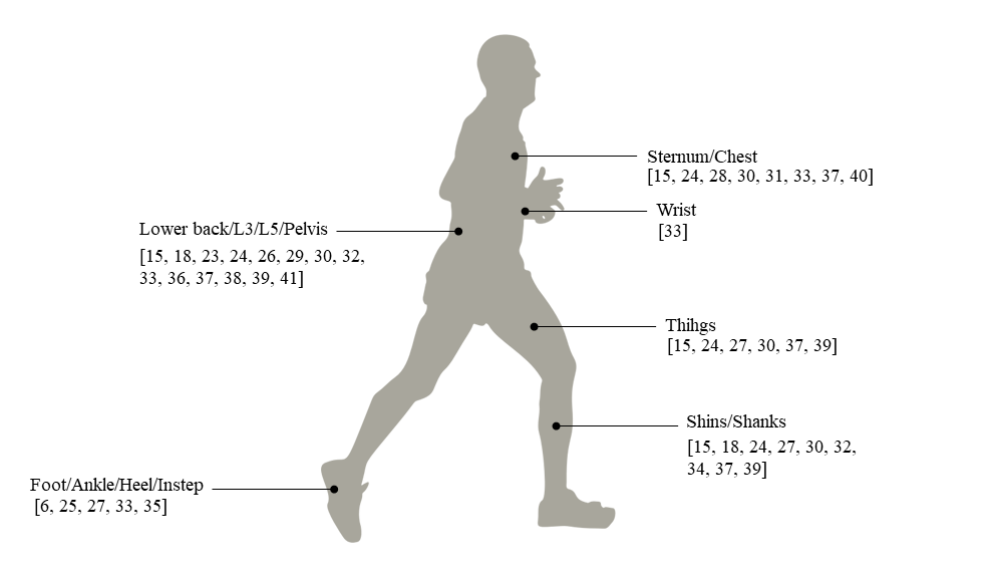
Figure 4. Sensors’ body locations and papers’